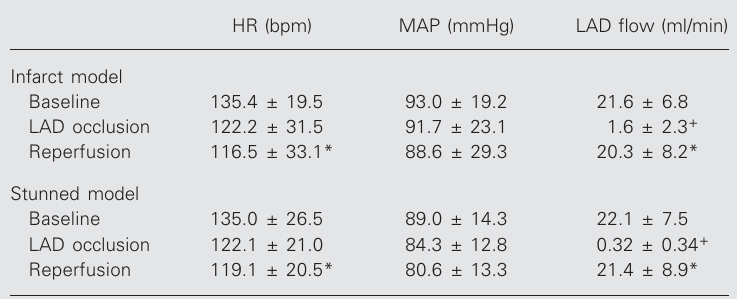
Data are reported as means ± SD. HR = heart rate; LAD = left anterior descending coronary artery; MAP = mean arterial blood pressure. *P < 0.05 vs LAD occlusion; + P ≤ 0.05 vs baseline (Friedman